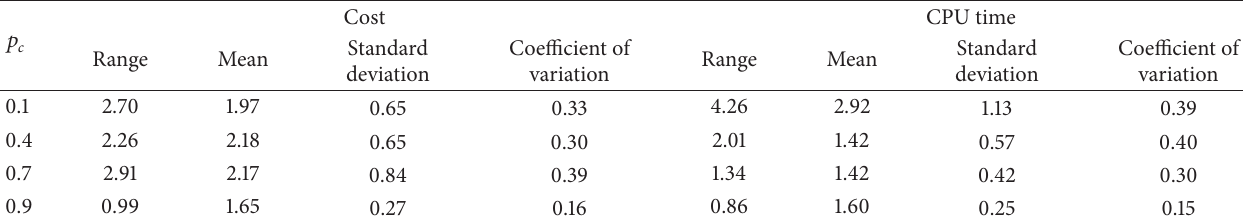
Table 2: The results with different 𝑝 𝑐 (cost: million yuan, CPU time: second). 𝑝